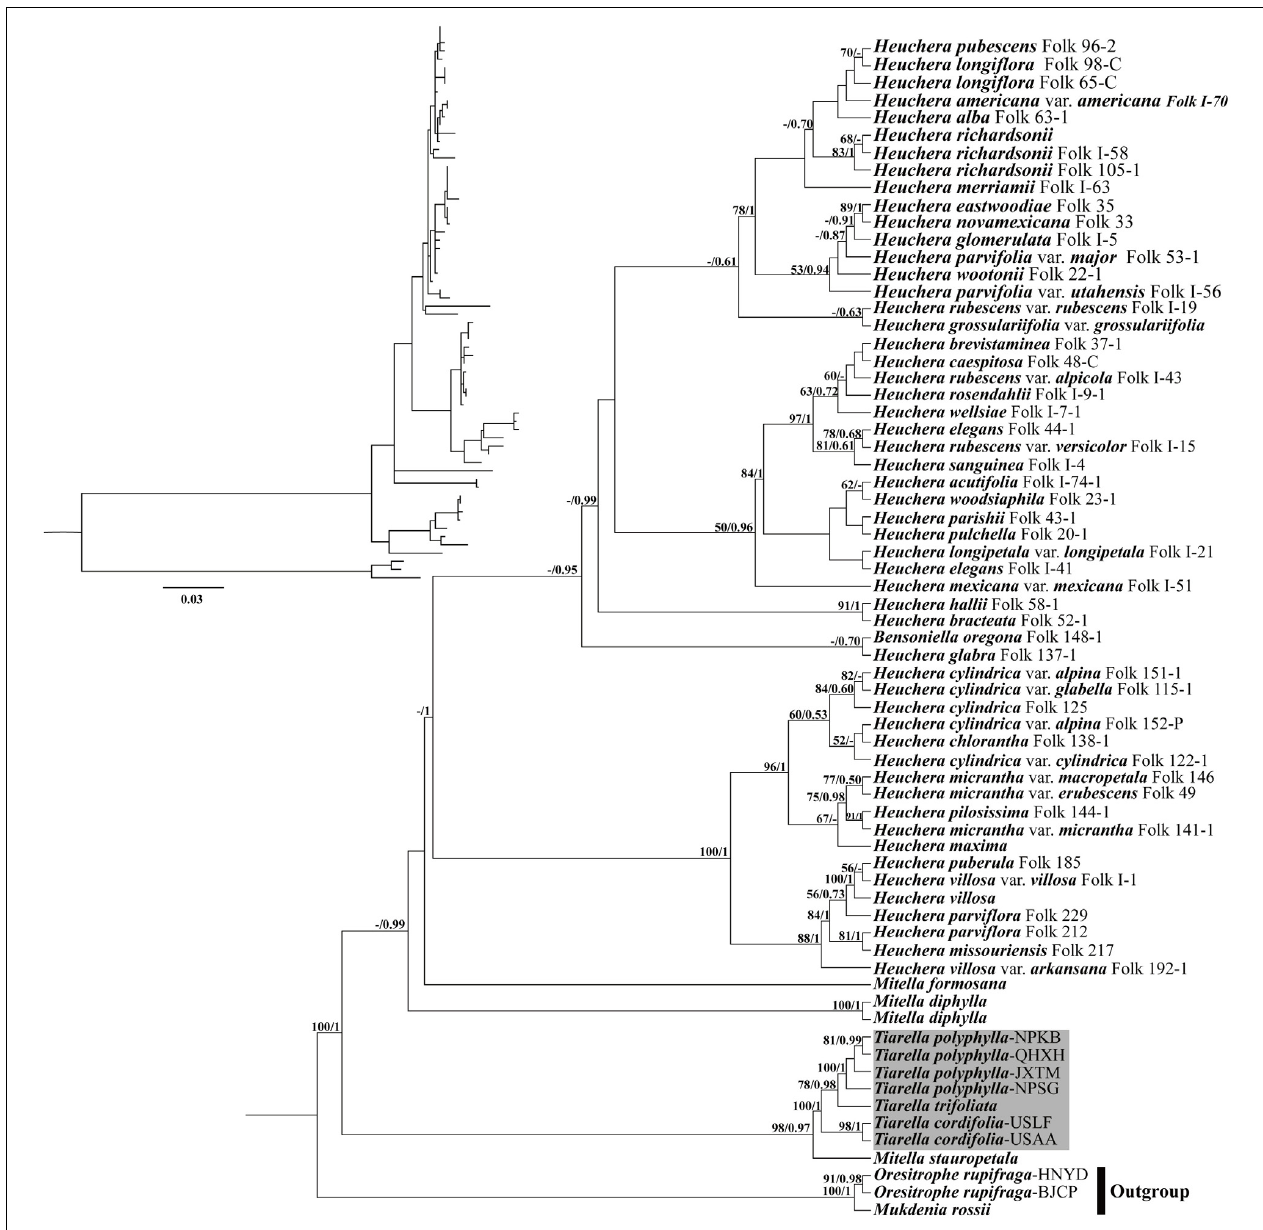
FIGURE 6 | Phylogenetic tree reconstruction using maximum likelihood (ML) based on ITS + ETS sequences. The inset topology in the upper left shows the relative branch lengths in per-site substitutions. Numbers above the branches represent ML bootstrap/Bayesian posterior probability (BS/PP). Hyphens indicate a bootstrap value or posterior probability <